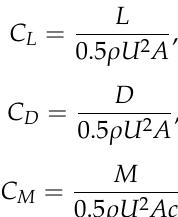
Figure 1. ( a ) Rectangular wing, ( b ) compound wing, and ( c ) compound wing explanation. Table 1. Principle dimensions of the compound and rectangular wings.